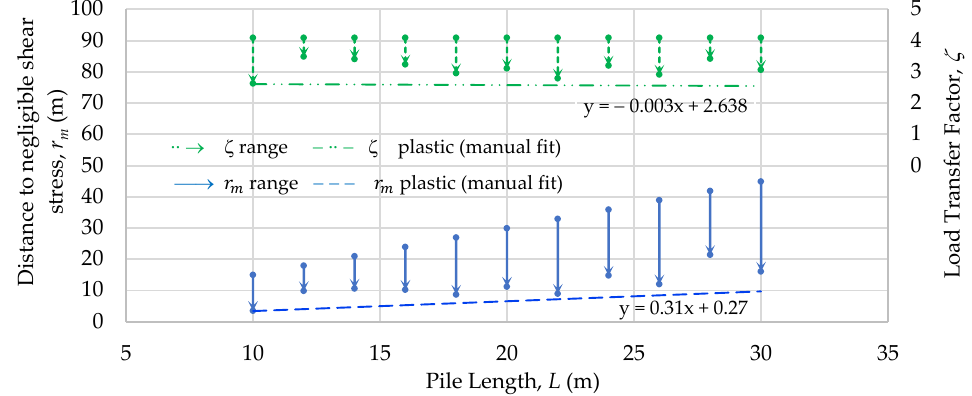
Figure 17. Change of the ζ and r m values as head load increases (slenderness ratio: L / r 0 = 40 and soil shear modulus: G = 3846 kPa).